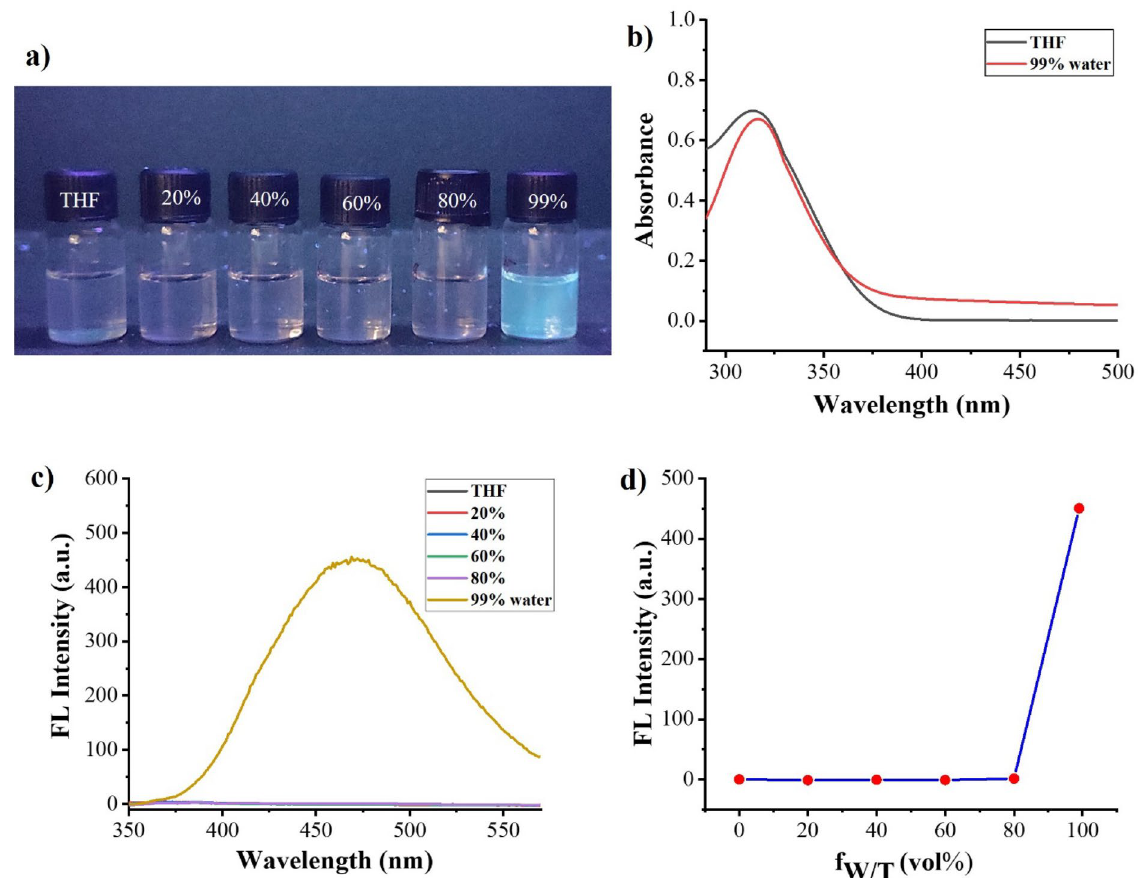
Figure 2. Images of TPE-kana 1 (5 × 10 −5 M) ( a ) in THF/H 2 O mixtures with different f w (0–99%) under 365 nm UV light. ( b ) UV–Vis absorption spectra in THF and THF/H 2 O f w (0–99%). ( c ) Fluorescence emission spectra of the TPE-kana 1 in THF/H 2 O ( v/v ratio) mixtures with different water fractions (λ ex = 310 nm) and ( d ) plot of relative fluorescence emission intensity as a function of f w .